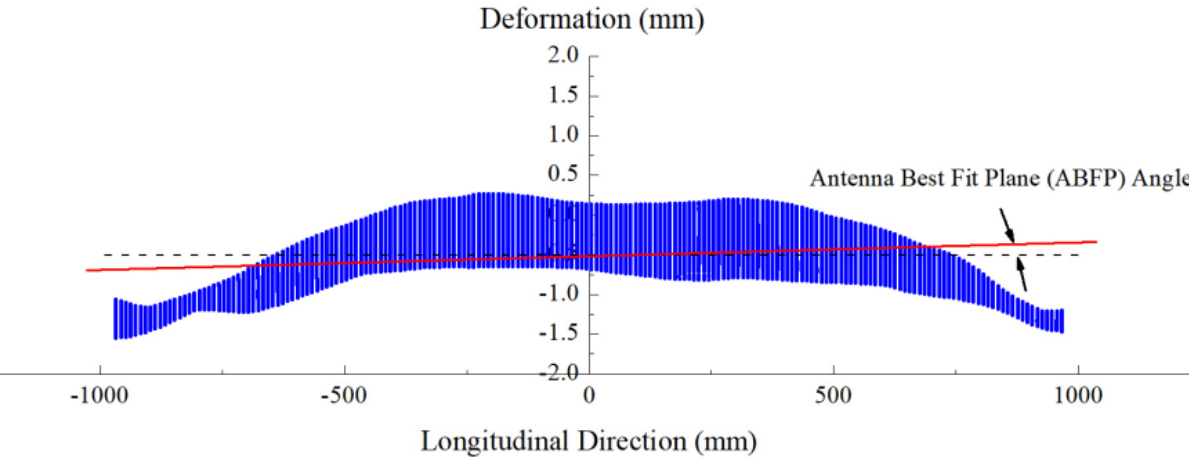
Figure 15. SAR antenna ABFP angle along the antenna longitudinal axis ( x -axis) resulting from the worst thermal gradient condition.